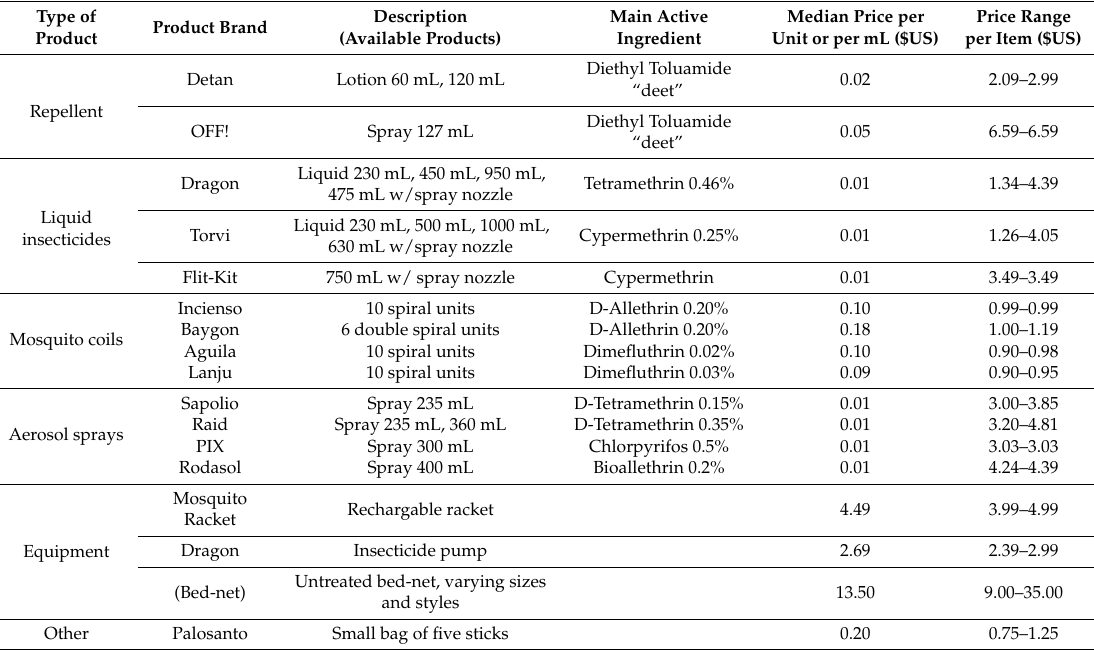
Table 3. Mosquito control and dengue prevention products available in markets in Machala in 2015.